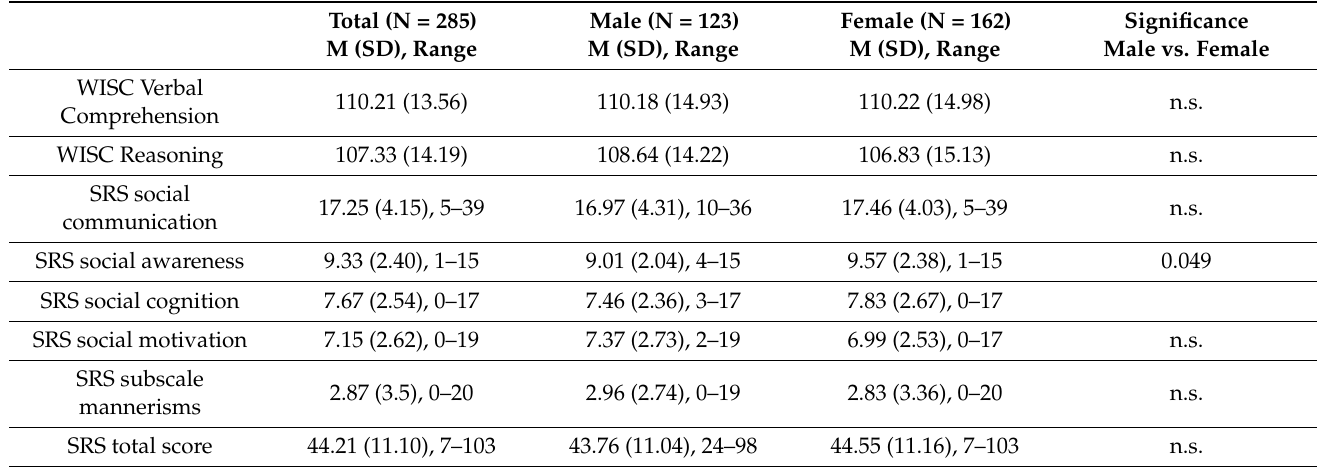
Table 1. Overview on demographic, intelligence and autistic trait